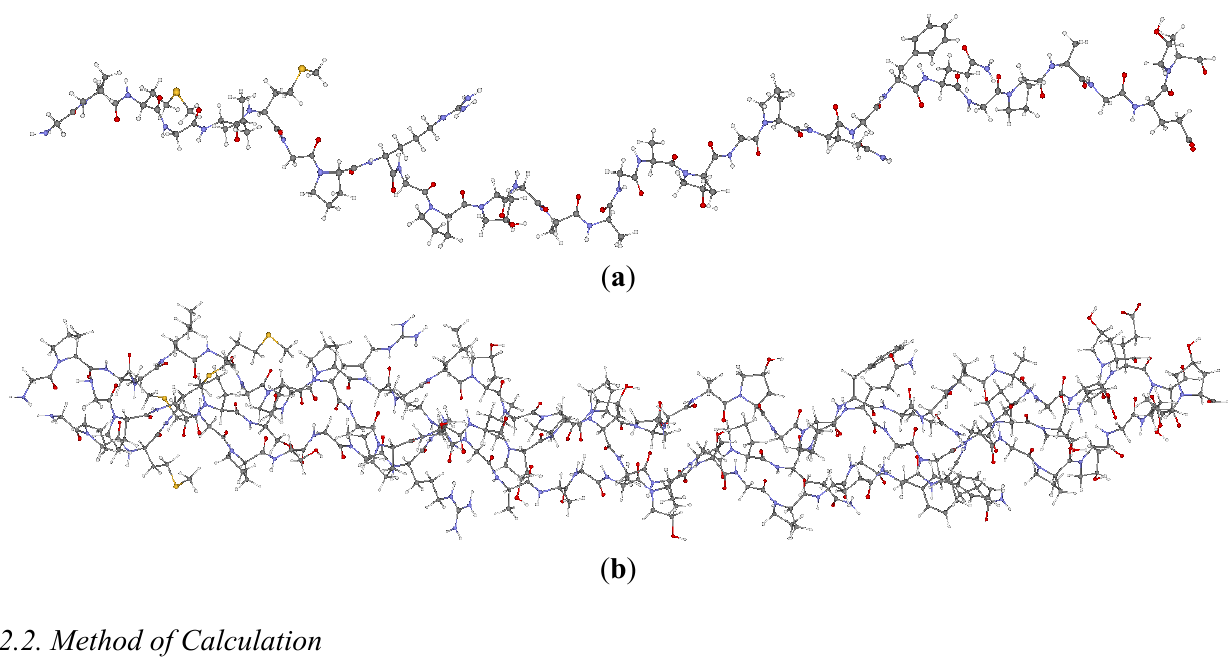
Figure 1. (Color on-line) ( a ) The single strand of α 2(I) chain in the 7-2 heterostructural model with the positions of Arg and Glu residues marked; and ( b ) The 7-2 heterostructural model with three strands, [ α 1(I)] α 2